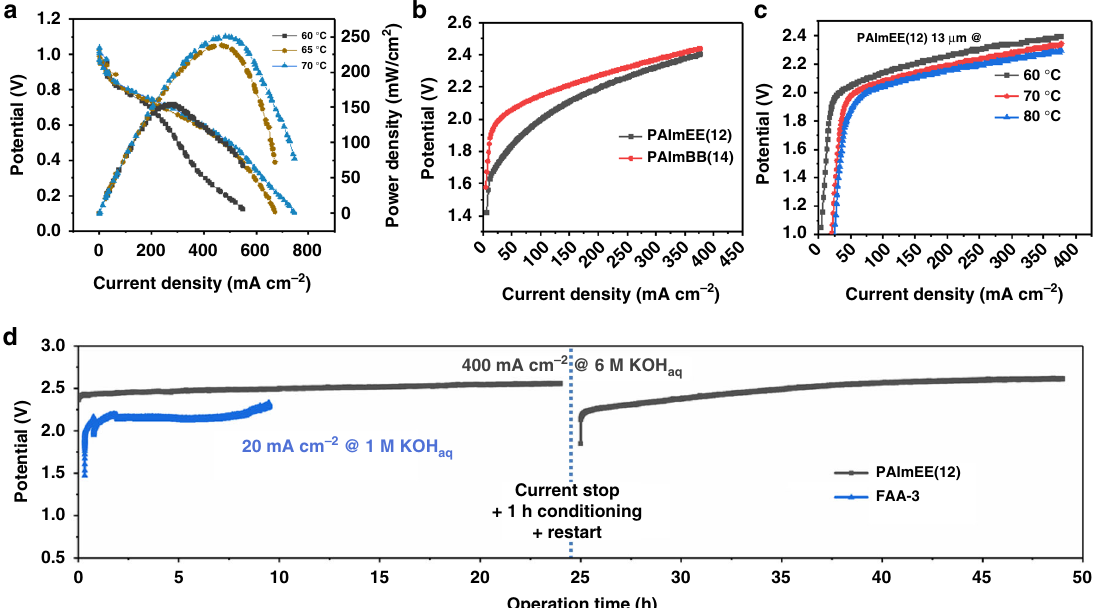
Fig. 7 I – V curves for fuel cells and water electrolyzers. a Polarization curves of PAImBB( 14 ) AEMFC with 0.5 mg PtRu per cm 2 (anode) and 0.5 mg Pt per cm 2 (cathode), and 20 μ m membrane thickness. Conditions were 60, 65, and 70 °C, respectively. Here, 1 mL min − 1 , zero back pressure. b Polarization curves of PAImEE( 12 ) [25 μ m thick] and PAImBB( 14 ) [20 μ m thick] AEM electrolyzer at 60 °C. c Polarization curves of PAImEE( 12 ) [13 μ m thick] AEM electrolyzer at 60, 70 and 80 °C in 6 M KOH. d PAImEE( 12 ), 25 μ m, maintained at 400 mA cm − 2 , and FAA-3, 25 μ m, at 20 mA cm − 2 at 60 °C. The difference in voltage between FAA-3 and PAImEE( 12 ) in c can be attributed to the different current densities at which the cell was operated Table 2 Chemical shift range used in degradation calculations Model Chemical shift Chemical shift compounds range for x t range for y